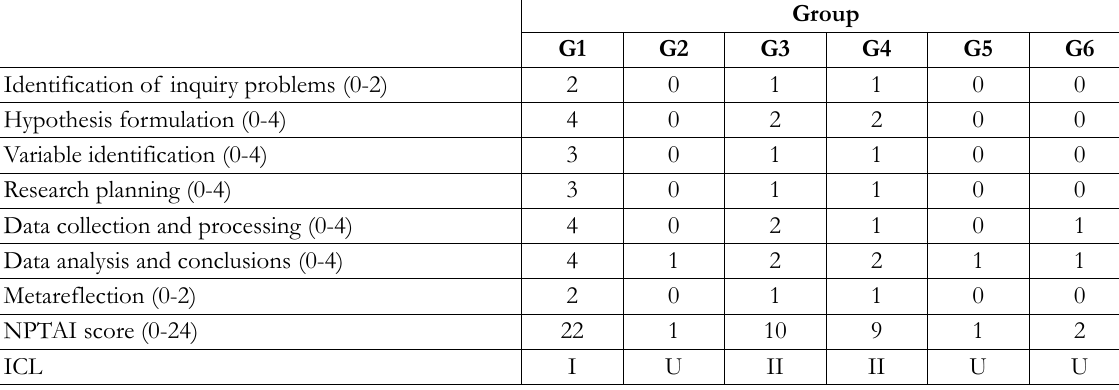
Table 3. NPTAI score and Inquiry Competence Level (ICL) obtained by each research